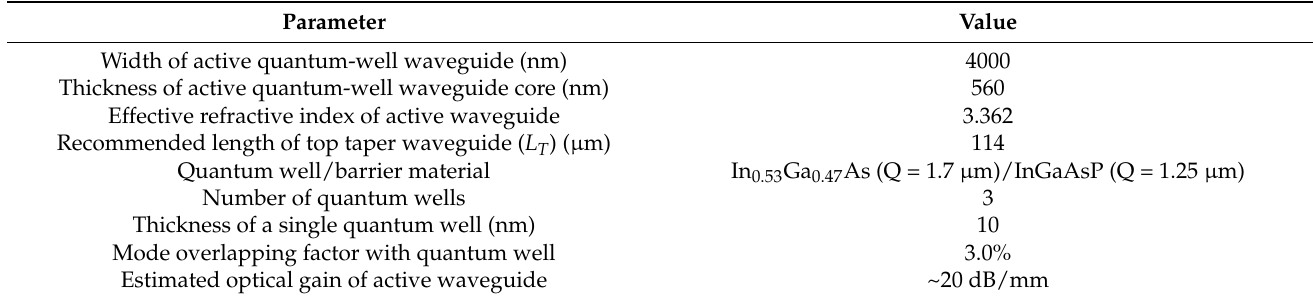
Table 3. Parameters used for the MQW active waveguide section.